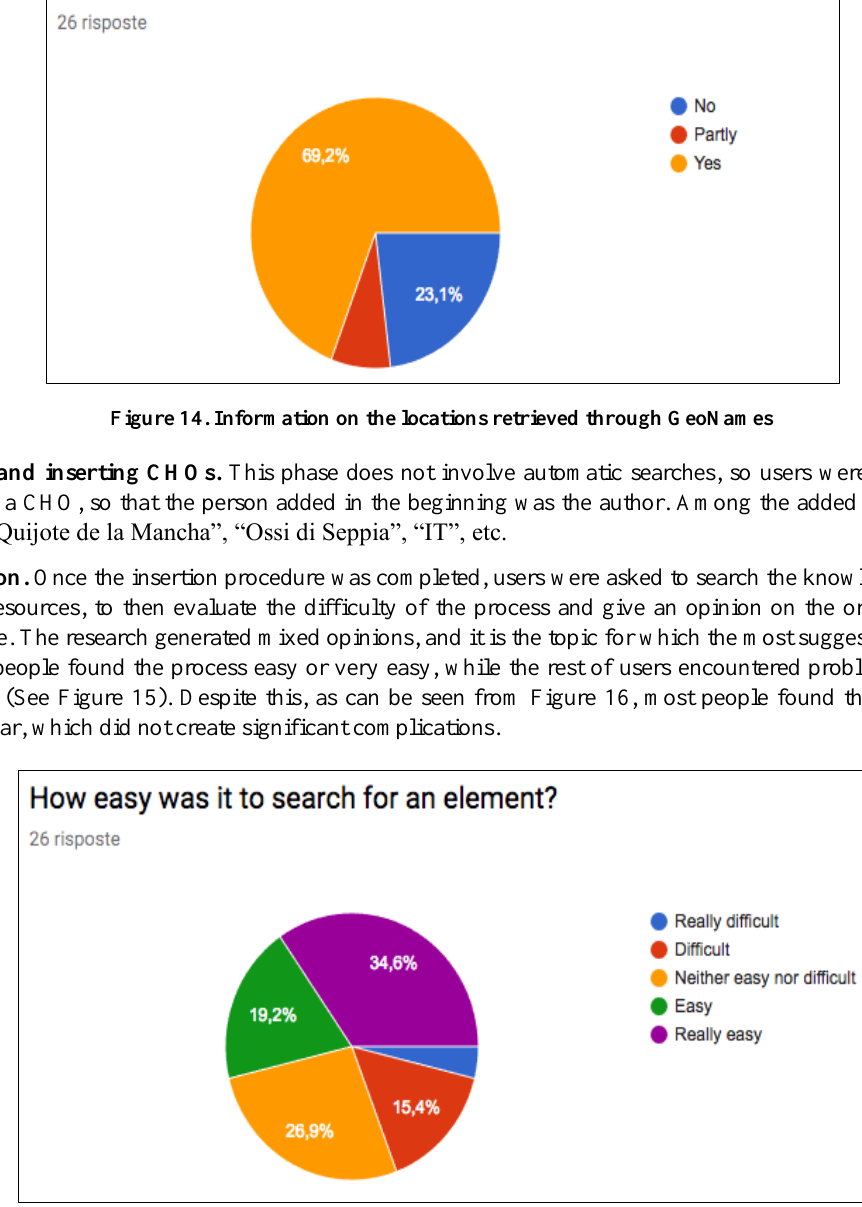
Figure 15. Difficulty of the search procedure within the knowledge